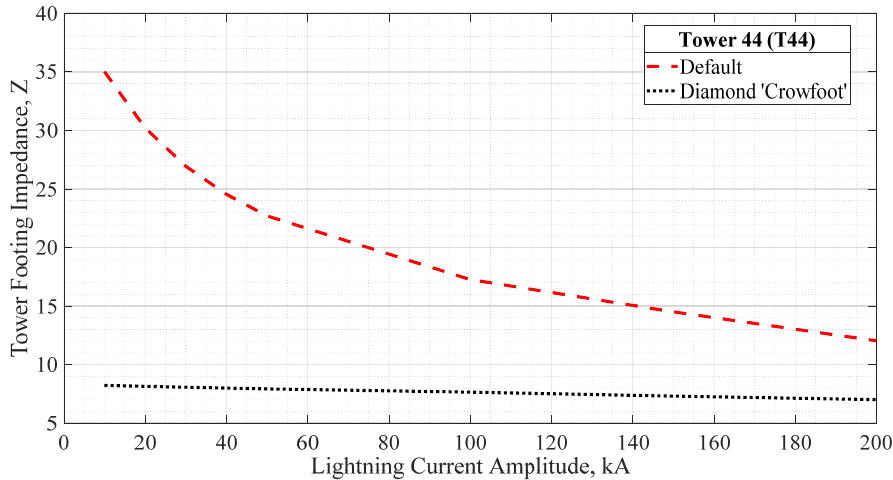
Figure 16. Variation of lightning current amplitude for Tower T44. Table 8. Tower footing impedance value for amplitude current variation before and after improvement. Lightning Current Magnitude, kA